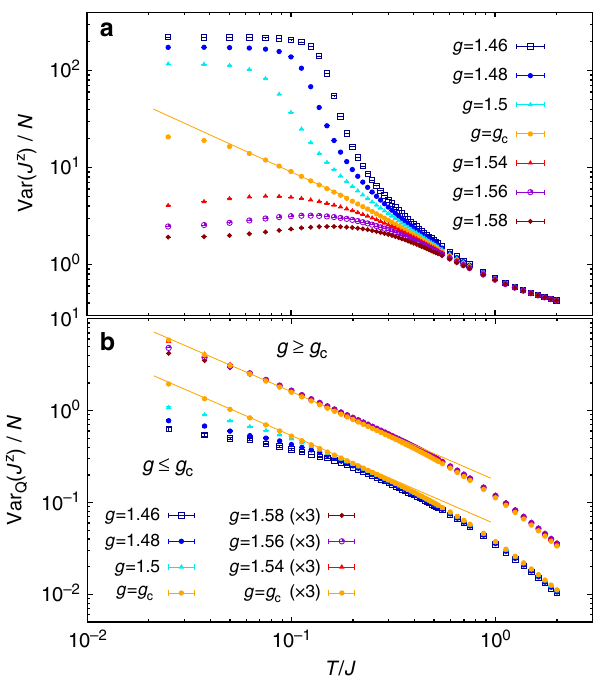
Fig. 2 Quantum-critical scaling in the 2d transverse- fi eld Ising (TFI) model. Temperature scaling of a the total variance and of b the quantum variance of the order parameter around the quantum critical point of the 2d TFI model (data have been obtained on a L = 64 lattice), for g = 1.46 (dark-blue squares), g = 1.48 (blue dots), g = 1.5 (light-blue triangles), g = g c (yellow dots), g = 1.5 (red triangles), g = 1.2 (purple circles), and g = 1.54 (dark-red diamonds). The quantum variance ( b ) above the quantum critical point ( g ≥ g c ) has been multiplied by a factor of 3 to improve readability. Solid lines are the QC scaling forms G (0) T − ψ (in ( a )) and G (Q) (0) T − ψ (in ( b )) respectively. Here, ψ = 0.964 …